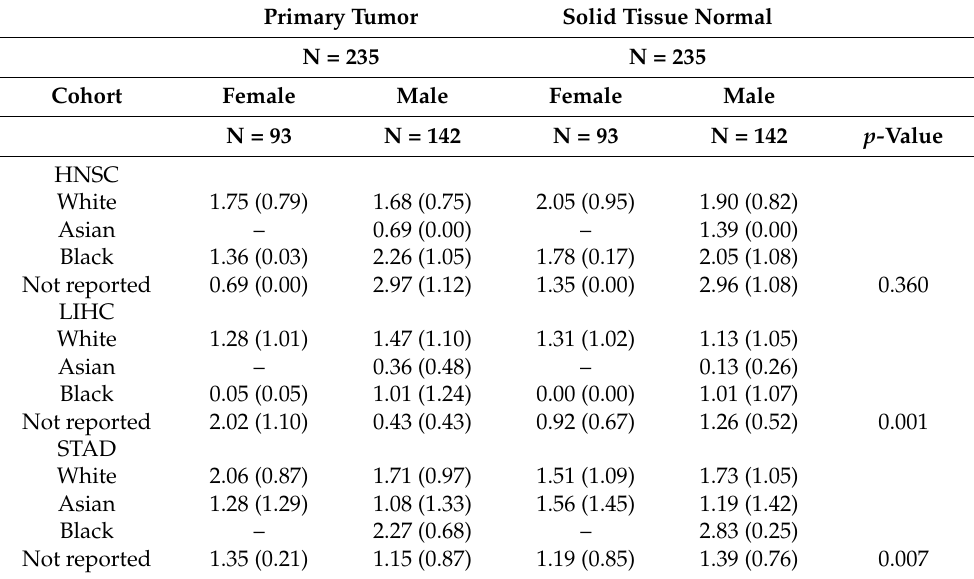
Table 3. Shannon-Wiener diversity index in tumor and adjacent normal paired